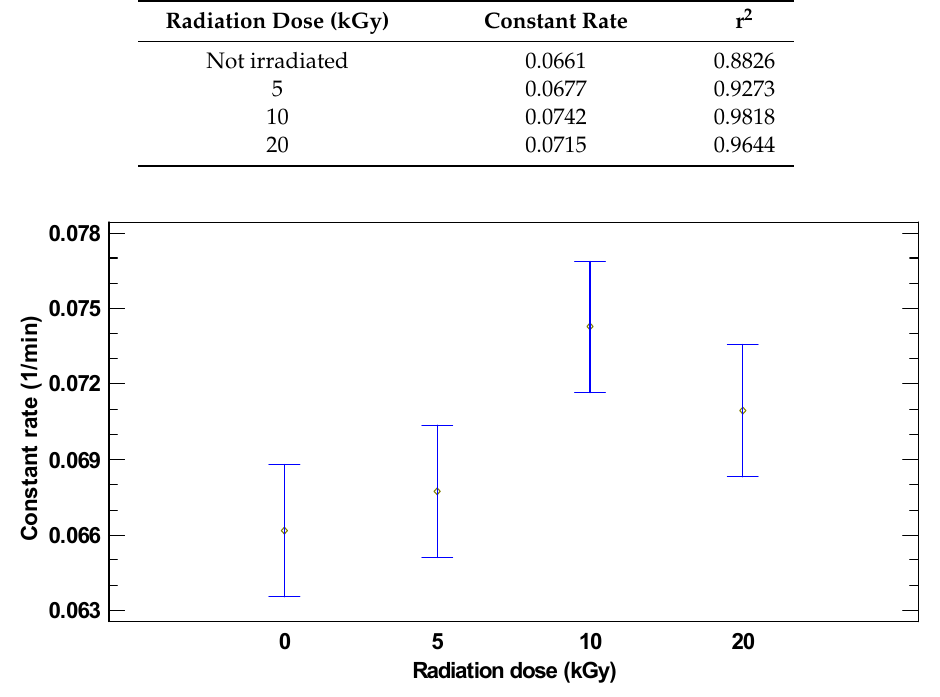
Figure 9. Statistical analysis of irradiation dose effect on the photodegradation of DB1. Conditions: C o, DB1 = 50 mg L −1 ; catalyst dose = 200 mg L −1 ; pH o = 2.5; T amb ≈ 20 °C.